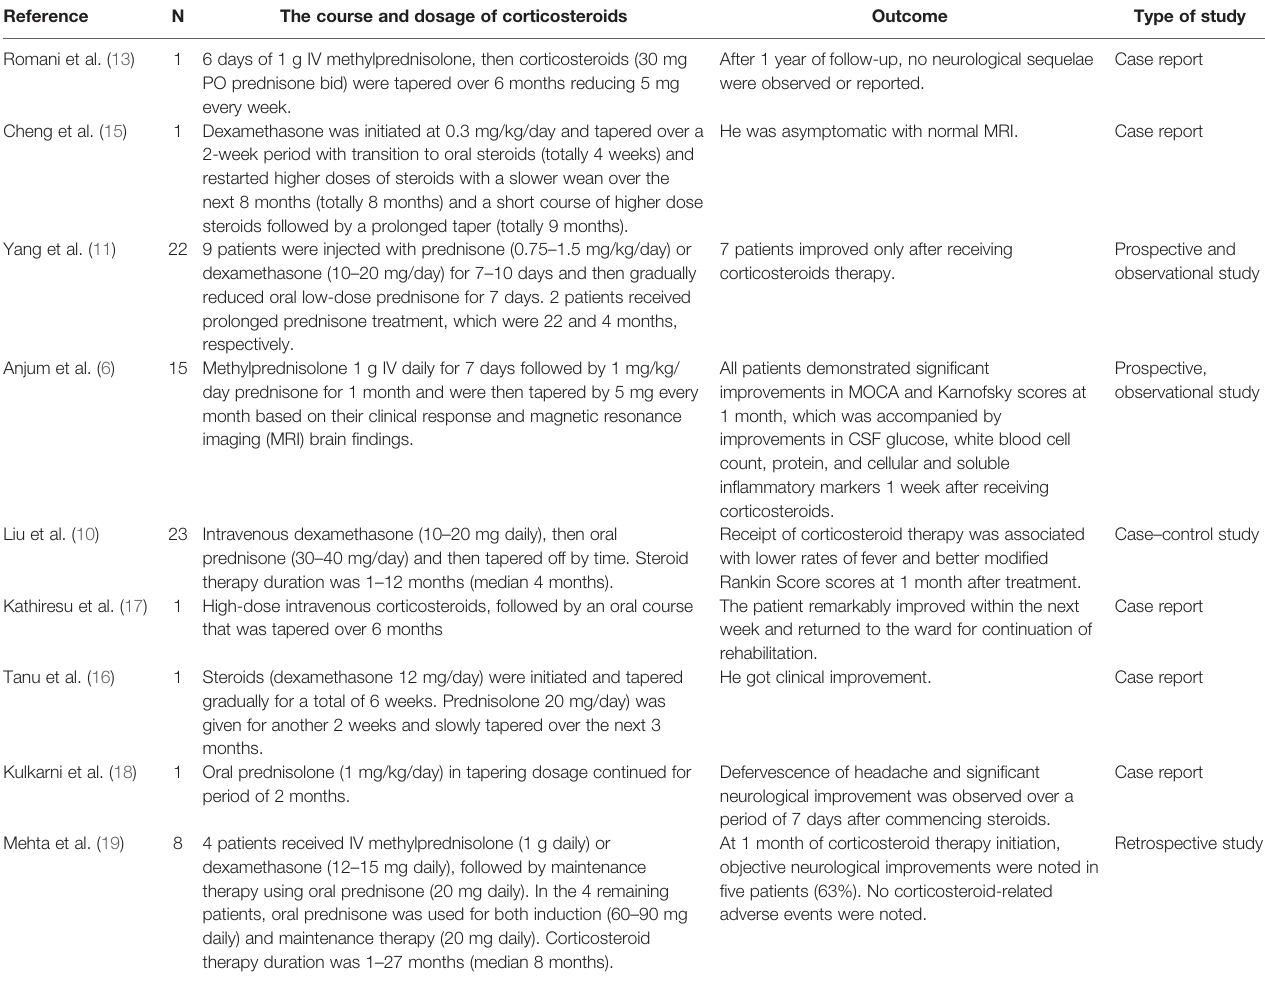
TABLE 1 | The course and dosage of corticosteroids for